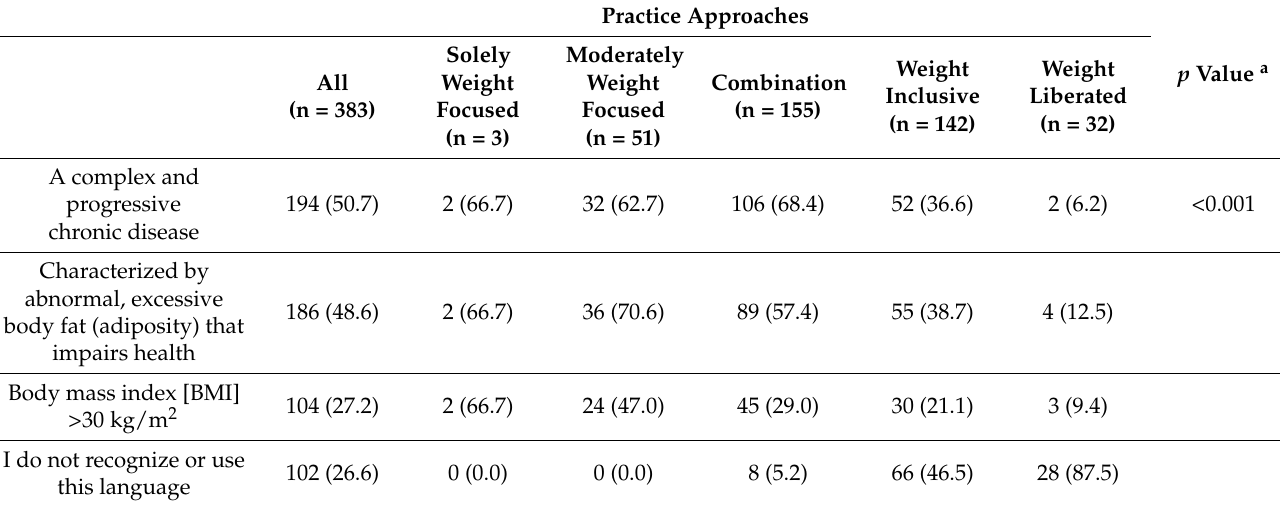
Table 4. Definitions of obesity by practice